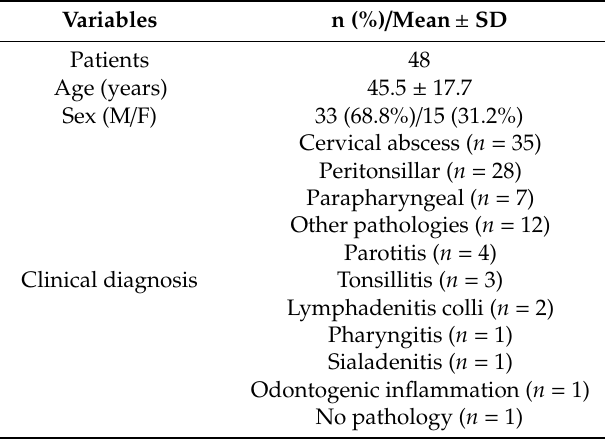
Table 1. Patient characteristics. M, male; F,